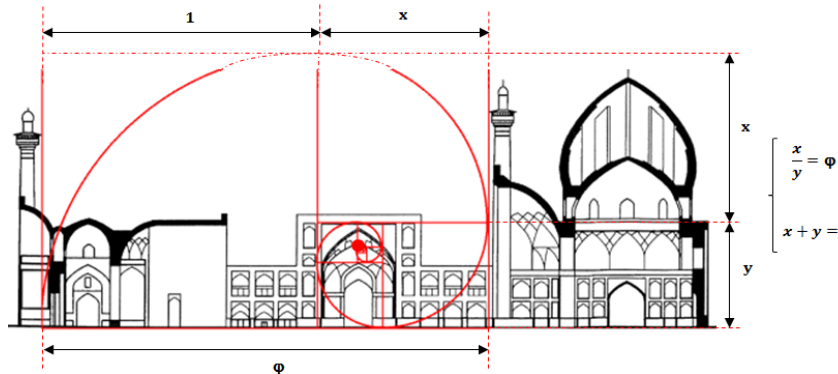
Figure 10: Abstract frame between two finials adapt with golden rectangle